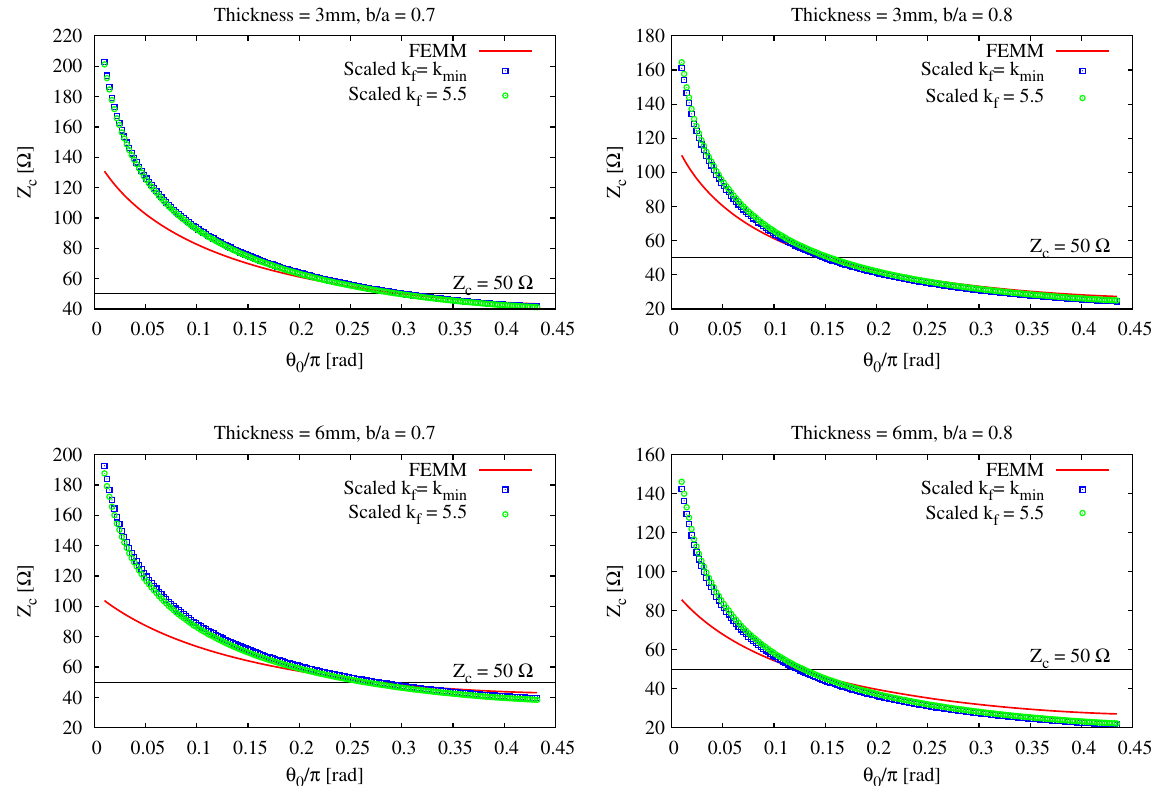
FIG. 15. Dipoles: Scaled impedance with thickness for two value of the fit parameter k FEMM as a function of θ 0 . Top row with t ¼ 3 mm; left plot b=a ¼ 0 . 7 , right plot b=a ¼ 0 . 8 . Bottom row with t ¼ 6 mm: left plot, b=a ¼ 0 . 7 , right plot b=a ¼ 0 . 8